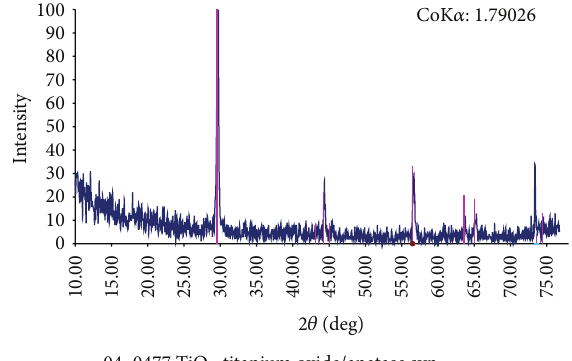
Figure 3: XRD pattern of TiO 2